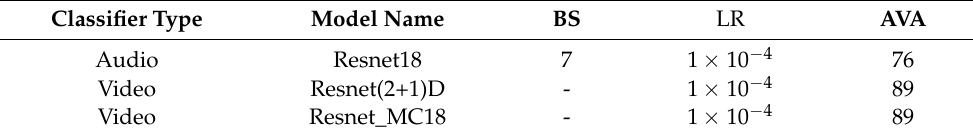
Table 11. Best average accuracy on the validation set by classifier